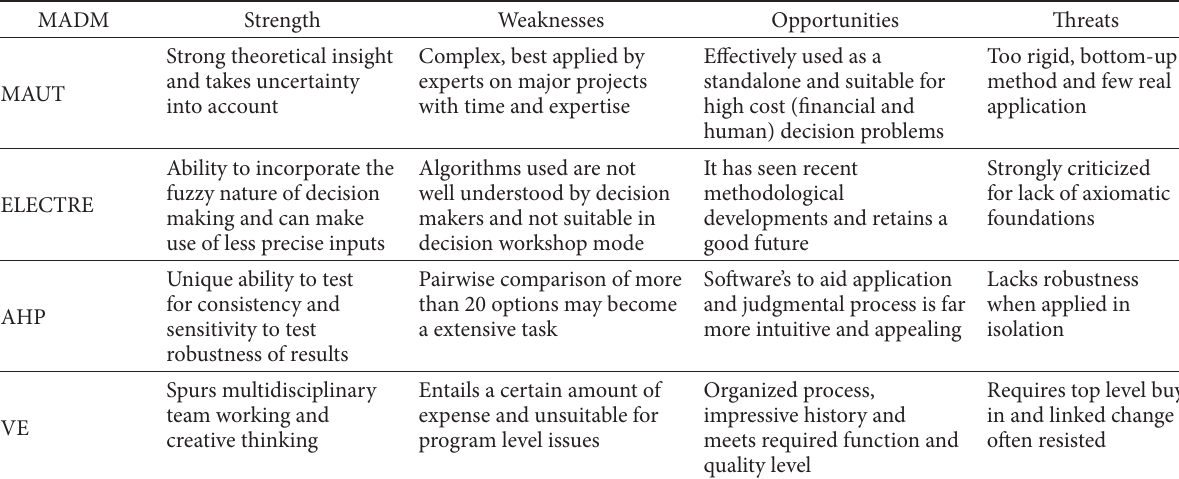
Table 1. Comparative Analysis of MADM Techniques MADM Strength